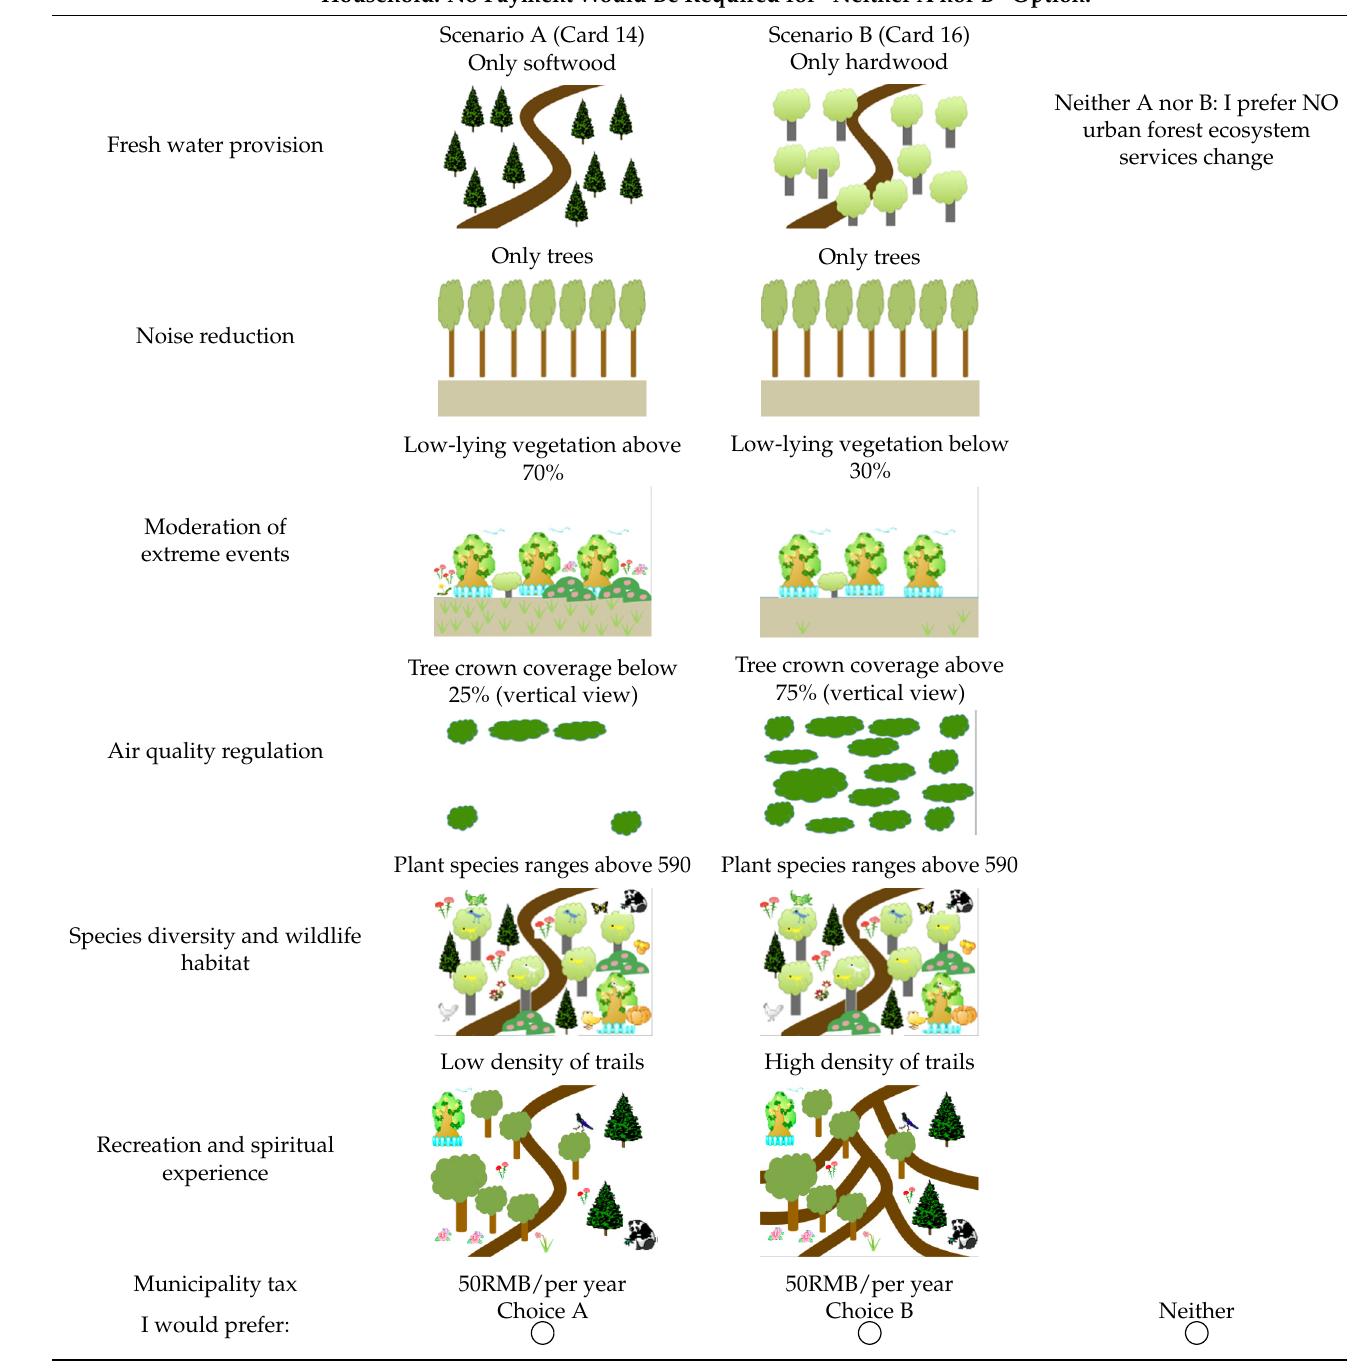
Table 6. Example of questionnaire with the choice set. Which of the Following Urban Forest Ecosystem Services Do You Favor? Option A and Option B Would Entail a Cost to Your Household. No Payment Would Be Required for “Neither A nor B” Option.